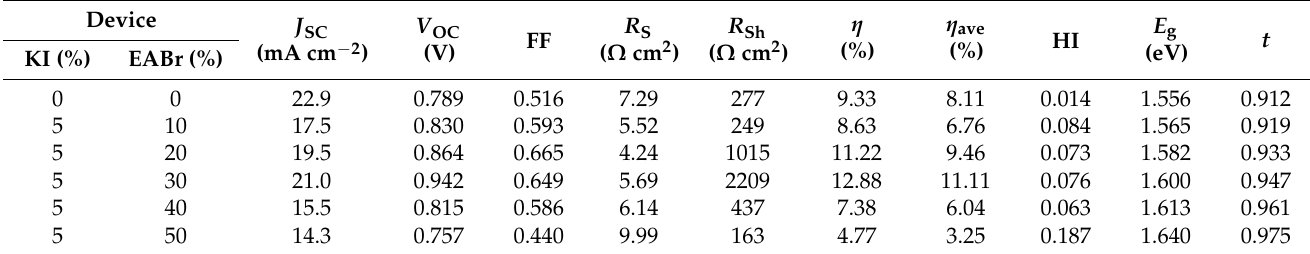
Table 1. Measured photovoltaic parameters of the present perovskite solar